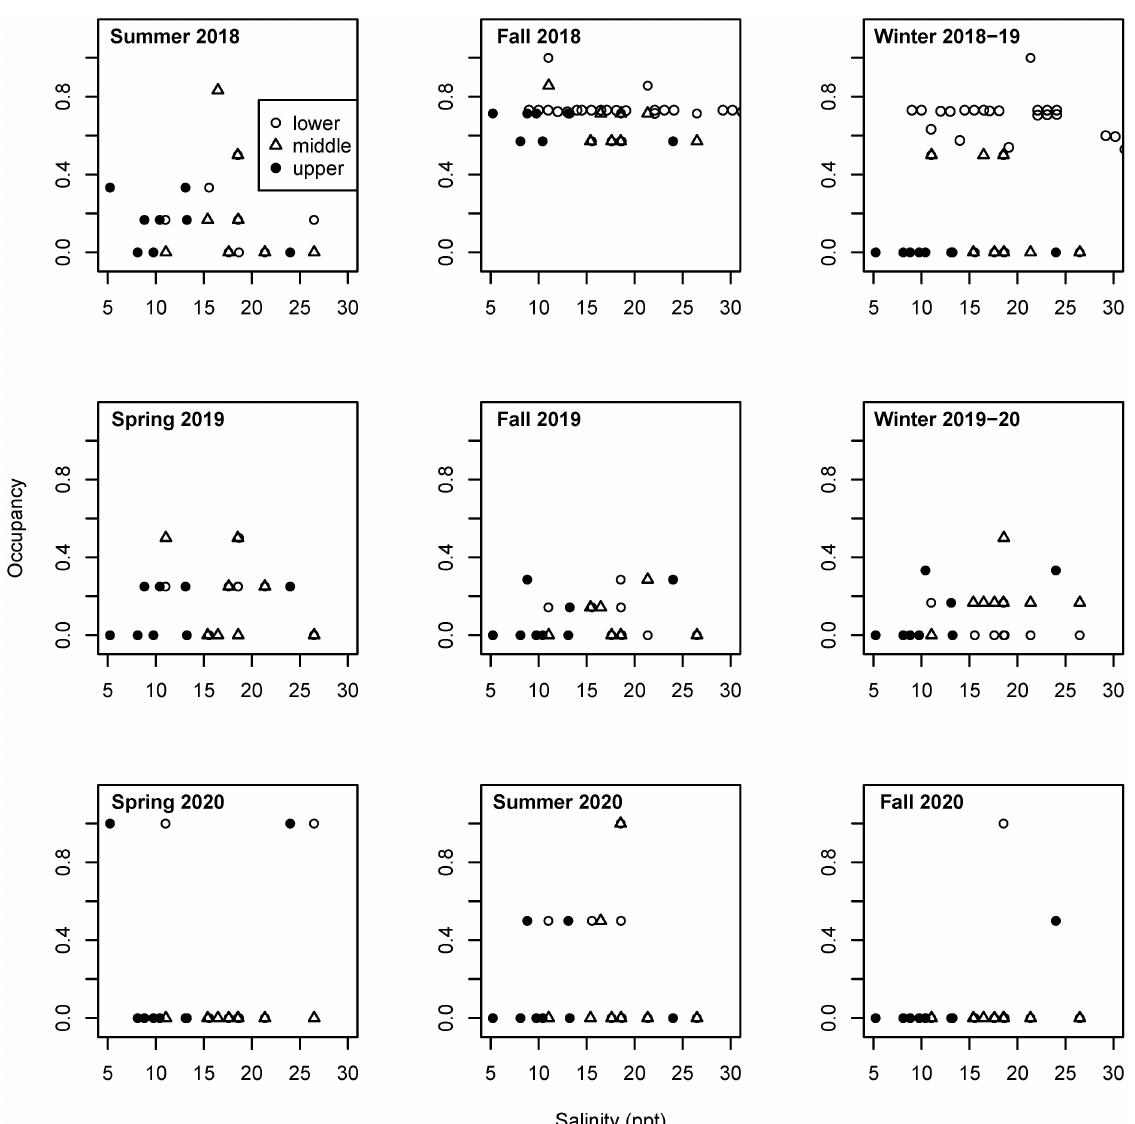
Figure 2. Cybersecurity Awareness Methodology. Figure 3. Observed proportional occupancy of juvenile blue crabs Callinectes sapidus ( y -axis) vs. mean salinity (parts per thousand: ppt) ( x -axis) at each of the three fixed sample sites in eight North Carolina (USA) tidal creeks. Sample sites are labeled according to their position in each creek: lower vs. middle vs. upper sites. The single legend (in the first panel) applies to all graph panels. No sampling occurred in summer 2019. Table 4. Median along with 2.5% and 97.5% quantiles for posterior probability distributions of modeled parameters from fitting an auto-logistic parameterization of a dynamic occupancy model to presence/absence data of juvenile blue crabs Callinectes sapidus across ten seasons in eight North Carolina (USA) tidal creeks. The table contains parameter values only for covariates retained in the final ecological and observation sub-models. See Supplementary Material S1 for model code.